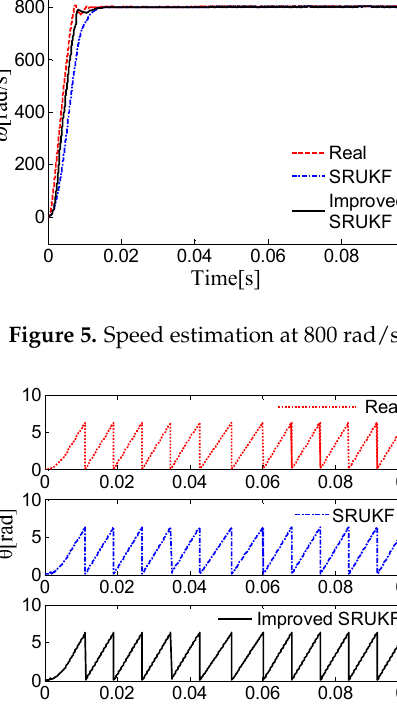
Figure 6. Space position estimation at 800 rad/s.